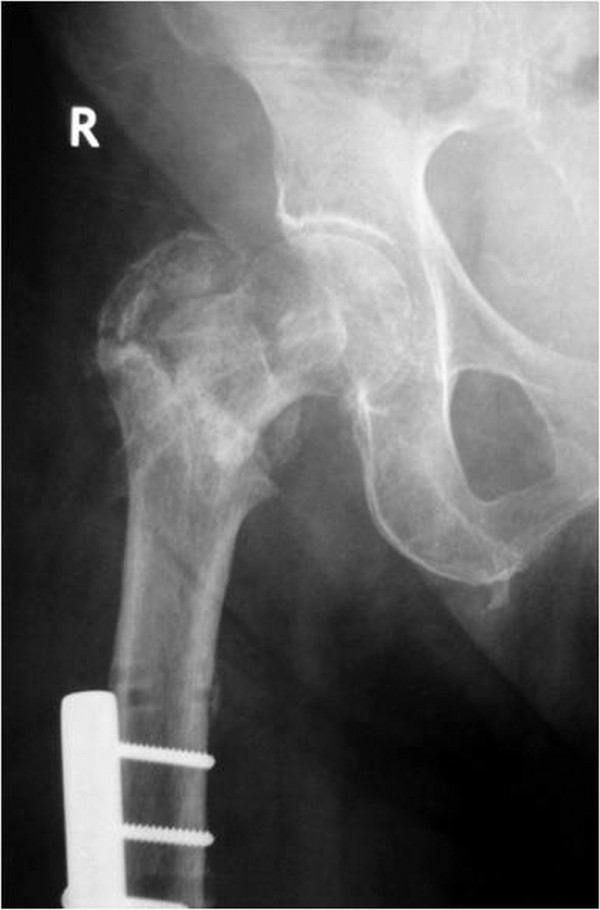
Complications. Re-fracture occurred after external fixator removal in one patient 15 weeks after surgery.